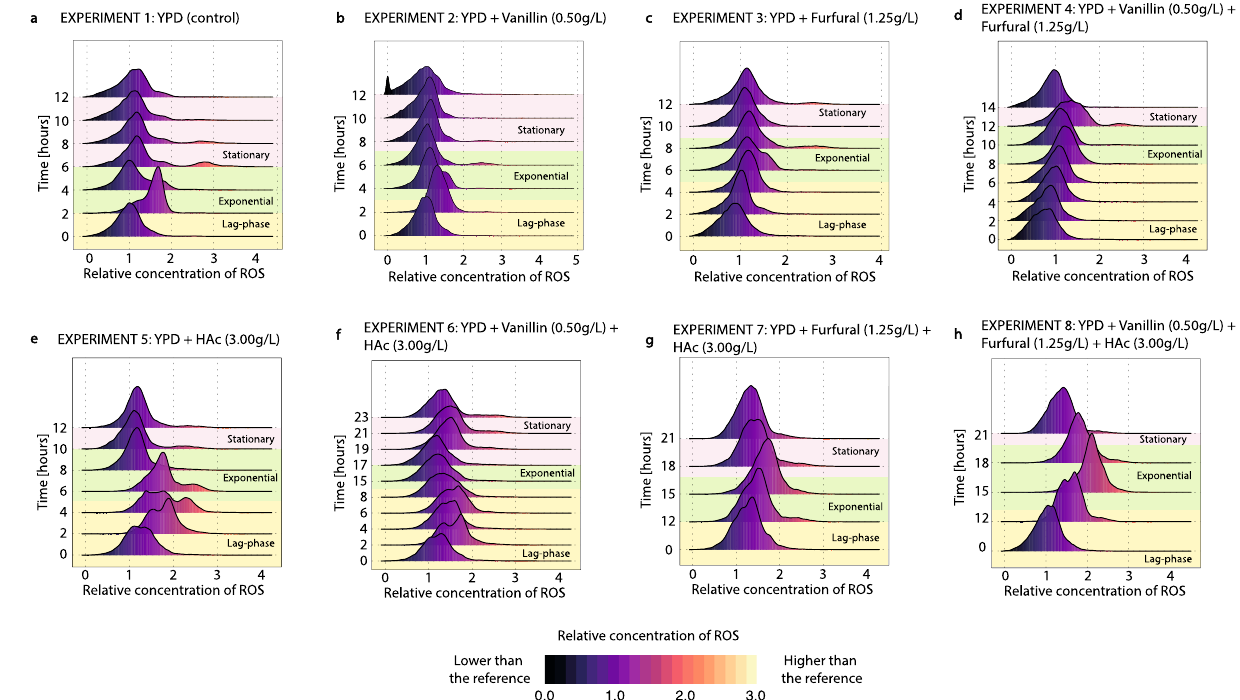
Figure 7. Evolution of the ROS concentration inside the cells during the experiments 1–8. The ROS concentration (measured using DHR123) is scaled by the mean of the ROS concentration in experiment 1 at time 0 h ( a ). The colour code indicates how far a population is from the reference point (i.e. orange and yellow indicate a higher ROS concentration than that of the reference population, while black and dark purple indicate a lower ROS concentration than in the reference population). This figure was produced using R 71 . ( a ) YPD control, ( b ) addition of vanillin (0.5 g/L), ( c ) addition of furfural (1.25 g/L), ( d ) addition of vanillin (0.5 g/L) and furfural (1.25 g/L), ( e ) addition of acetic acid (3 g/L), ( f ) addition of vanillin (0.5 g/L) and acetic acid (3 g/L), ( g ) addition of furfural (1.25 g/L) and acetic acid (3 g/L), ( h ) addition of vanillin (0.5 g/L) furfural (1.25 g/L) and acetic acid (3